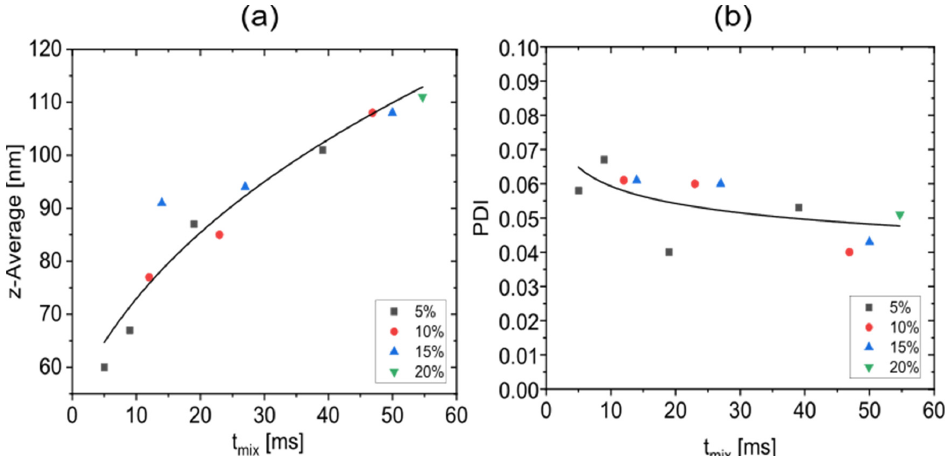
Figure 10. The correlation between the mixing times obtained with the digital CLM twin with three stretch-and-fold units and experimental data (each data point represents the average size of three measurements) obtained with the real CLM [28]. The data points include all considered flow rate ratios. ( a ) Correlation with nanoparticle sizes (z-average). The drawn curve shows a fit to the data points assuming z average3 = z 03 + k ∗ t mix . ( b ) The correlation of mixing time with the mean (from three experiments obtained) PDI values which are more scattered, is much weaker. The drawn curve therefore indicates a trend